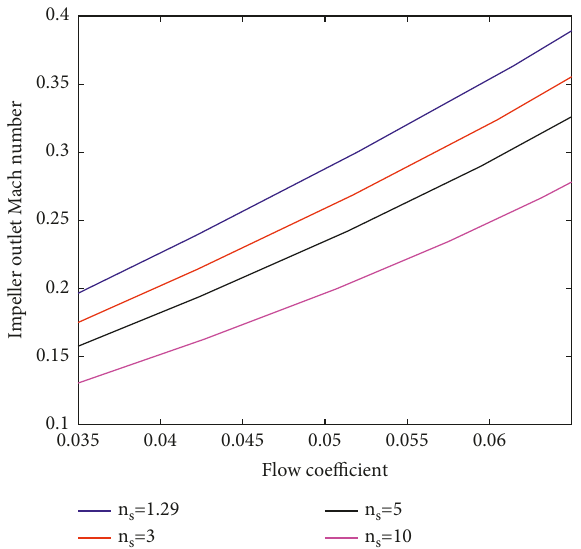
Figure 8: Isentropic exponent effects on the Mach number at the impeller suction